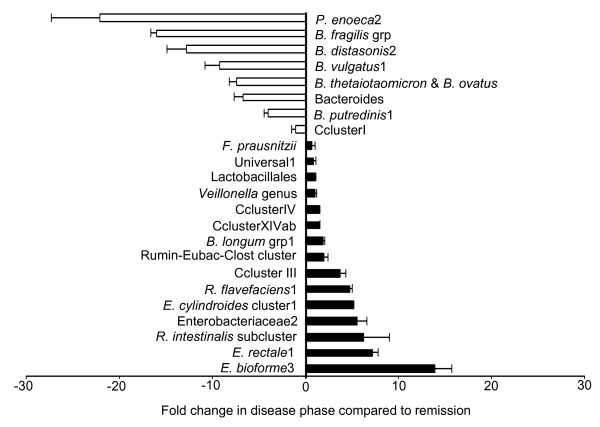
GI tract bacterial changes in an Ulcerative Colitis patient during the disease state compared to remission. Selection of bacterial probes showing the fold change in signal intensity during the disease phase compared to remission, in a patient suffering UC. Black bars indicate probes whose signal is greater in the disease state and white bars are those probes which are greater in remission. Probe identities for the black bars are to the left of zero on the x axis and white bar probe identities are to the right of zero. The error bars represent the standard error.